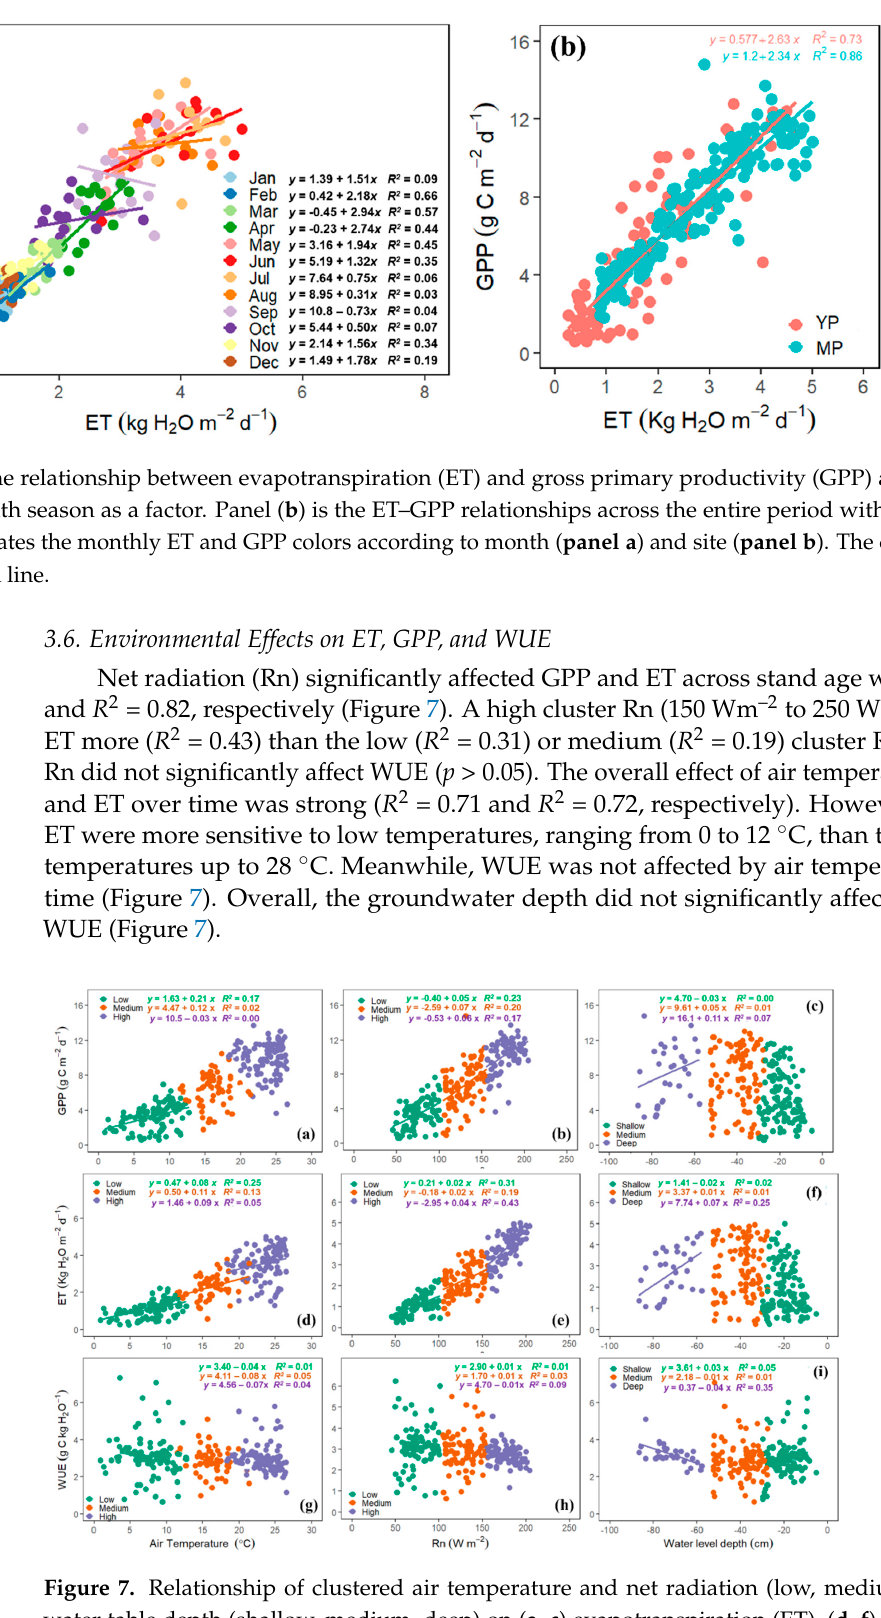
Figure 7. Relationship of clustered air temperature and net radiation (low, medium, high) and water table depth (shallow, medium, deep) on ( a – c ) evapotranspiration (ET), ( d – f ) gross primary productivity (GPP), and ( g – i ) water use efficiency (WUE) across all years at YP and MP combined. Each circle indicates the monthly ET, GPP, and WUE colors according to the cluster for each variable. The color line indicates the regression line for each cluster